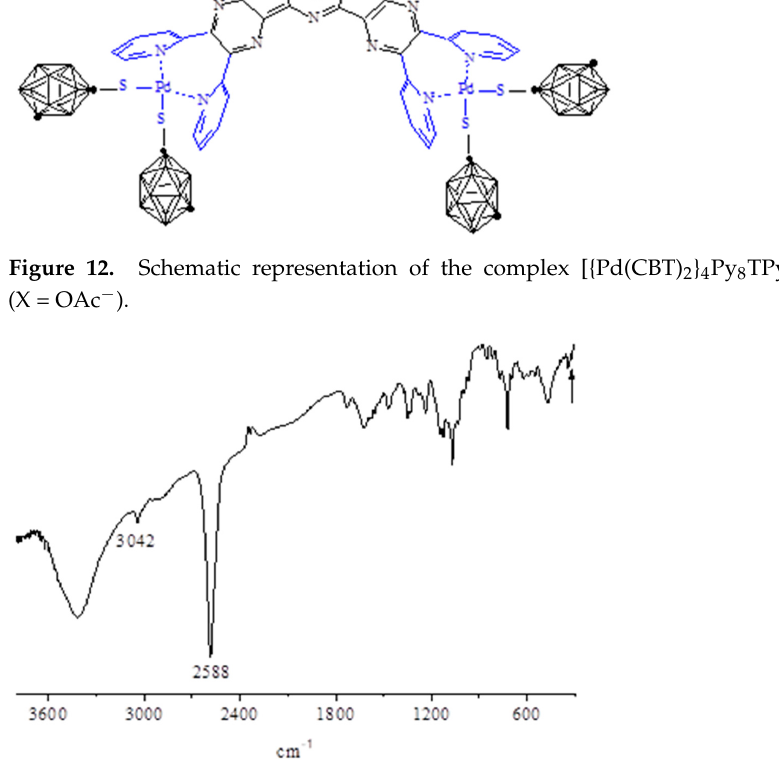
[{Pd(CBT 2 )} 4 Py 8 TPyzPzM] [17] also carrying externally Pd(CBT) 2 units with the